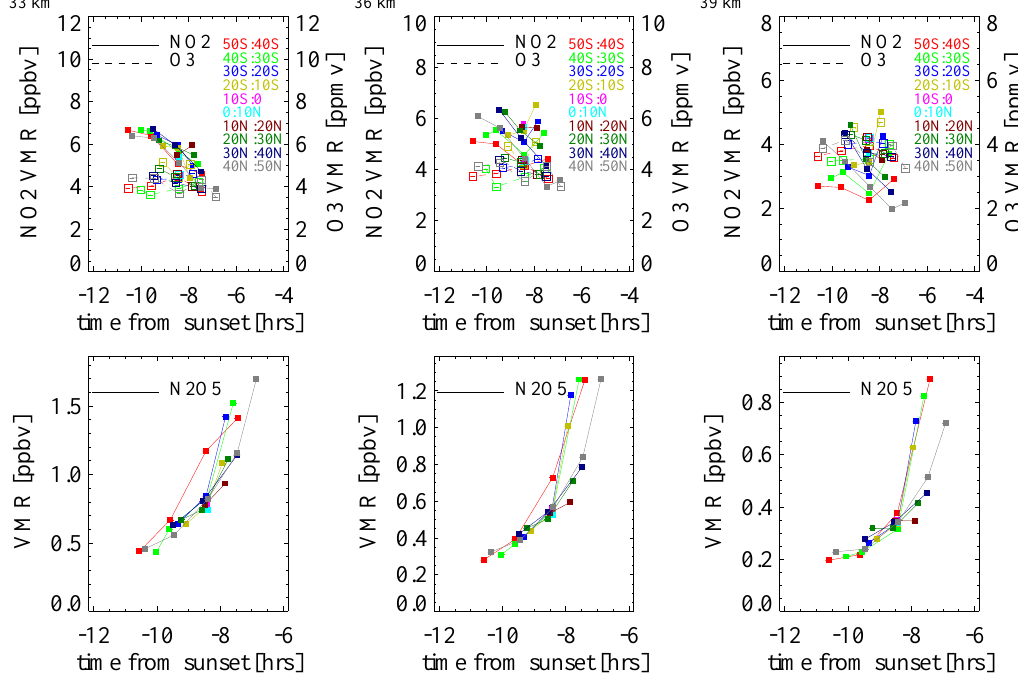
Fig. 4. Top panel shows the measured daytime concentrations of NO 2 and ozone binned by hour from sunset in 10 ◦ latitude bands where 50–40 ◦ S is shown in red, 40–30 ◦ S in light green, 30–20 ◦ S in dark blue, 20–10 ◦ S in yellow, 10–0 ◦ S in pink, 0–10 ◦ N in light blue, 10–20 ◦ N in maroon, 20–30 ◦ N in dark green, 30–40 ◦ N in navy blue, and 40–50 ◦ N in grey. Bottom panel shows the measured daytime concentrations of N 2 O 5 binned in the same way. These measurements were used to initialise the photolysis calculations to calculate the sunset values of N 2 O 5 using the TUV. The calculated sunset values are shown in the bottom panel of Fig. 3. Error bars indicate error in mean.